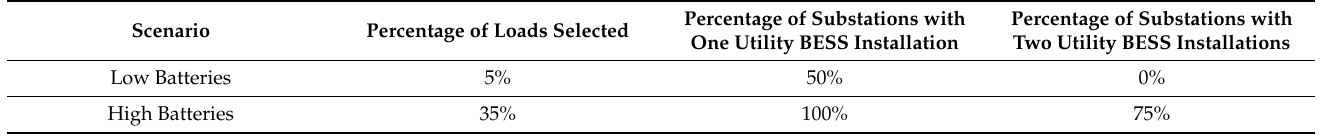
Table 2. Distribution buses with battery energy storage added in low and high